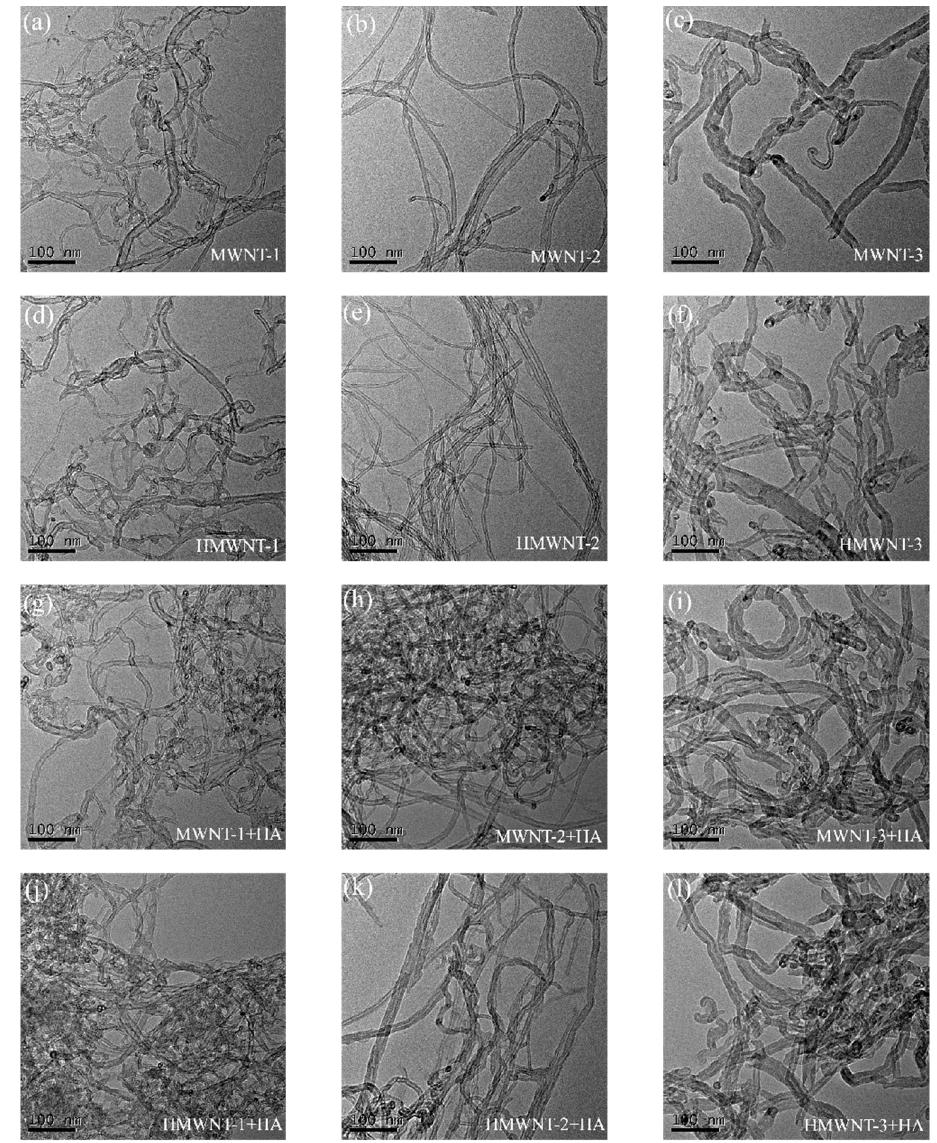
Figure 1. TEM images of MWNTs ( a – c , g – i ) and HMWNTs ( d – f , j – l ) prior to and after HA adsorption.